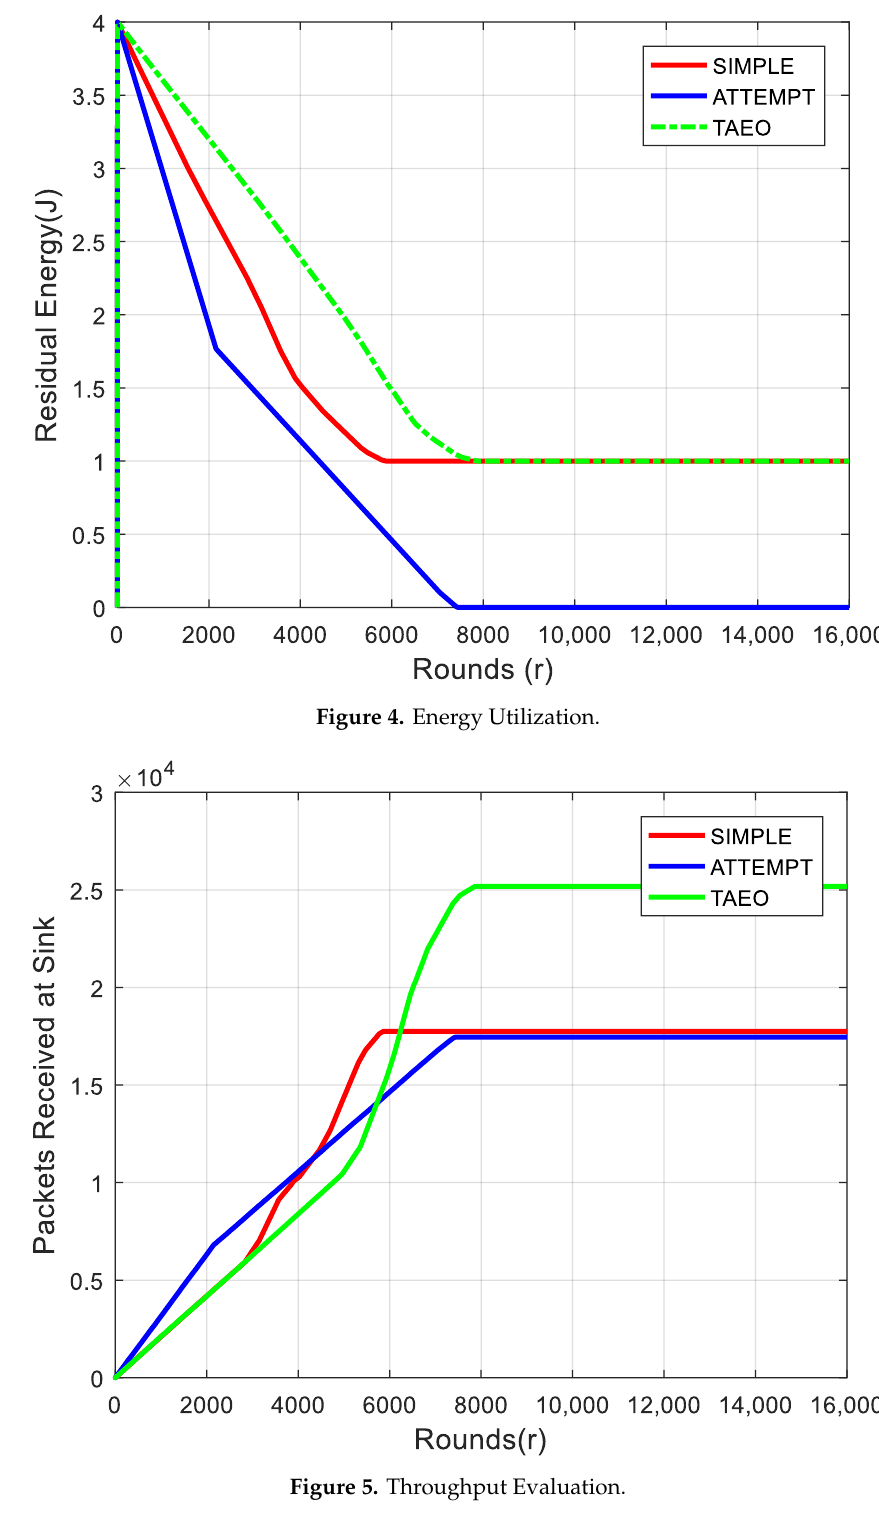
Figure 5. Throughput Evaluation.